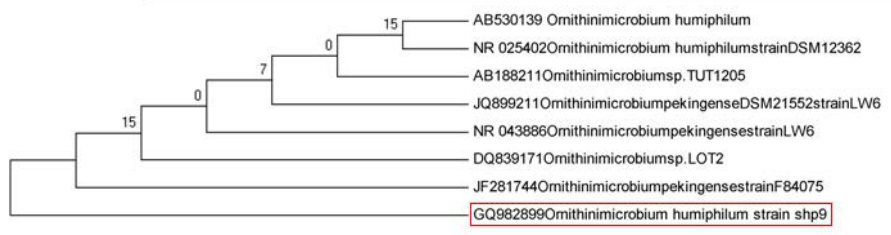
Fig. 9. Phylogenetic analysis of RAtM-3